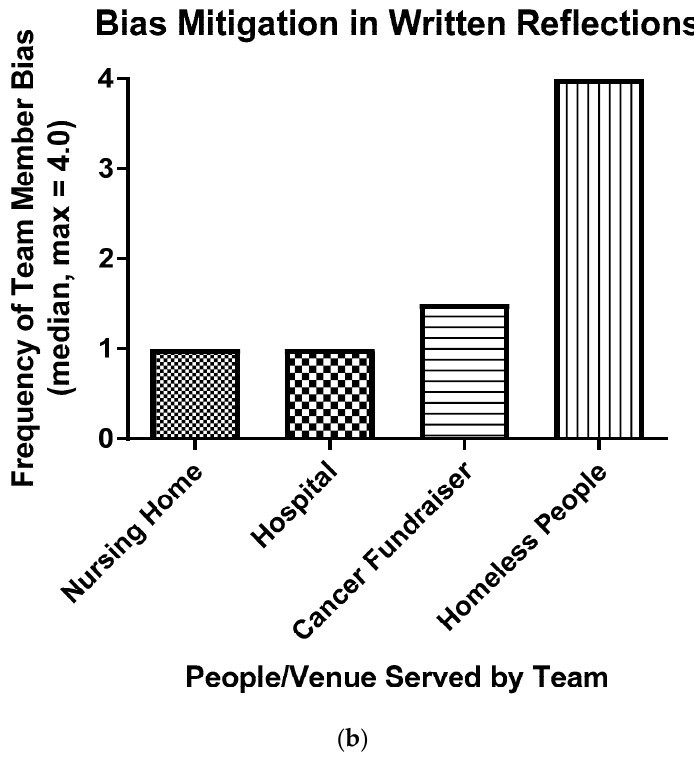
Figure 2. One team performed self-examination somewhat less frequently ( a ) while another team mitigated biases more frequently ( b ) than the other three teams. The median frequencies of self-examination and bias mitigation by each student on four separate occasions were calculated from 100 individual written reflections (four per student and six or seven students per team). One student’s performance was a statistically significant outlier in ‘a’ and another in ‘b’, and they were not included in the analyses ( p < 0.05). While self-examination occurred somewhat less frequently in one team ( p < 0.05), and bias mitigation was more frequent in another ( p = 0.02) (Kruskal–Wallis statistic), each median is significantly greater than zero ( p < 0.05) (Wilcoxon test). Table 3. Summary of biases expressed by students (Item 11 of Table 1) in the survey about their team service-learning experiences (19 of 26 students stated one or more of their biases). Nature of Negative Bias Number of Times Expressed Homeless People 5 Culture/Race 5 Older People 3 Attitudes of Other People 3 Gender 2 People with Serious Diseases 2 Other Healthcare Providers 2 Nonclinical Settings for Service 1 Hospital Volunteering 1 Socioeconomic Status 1